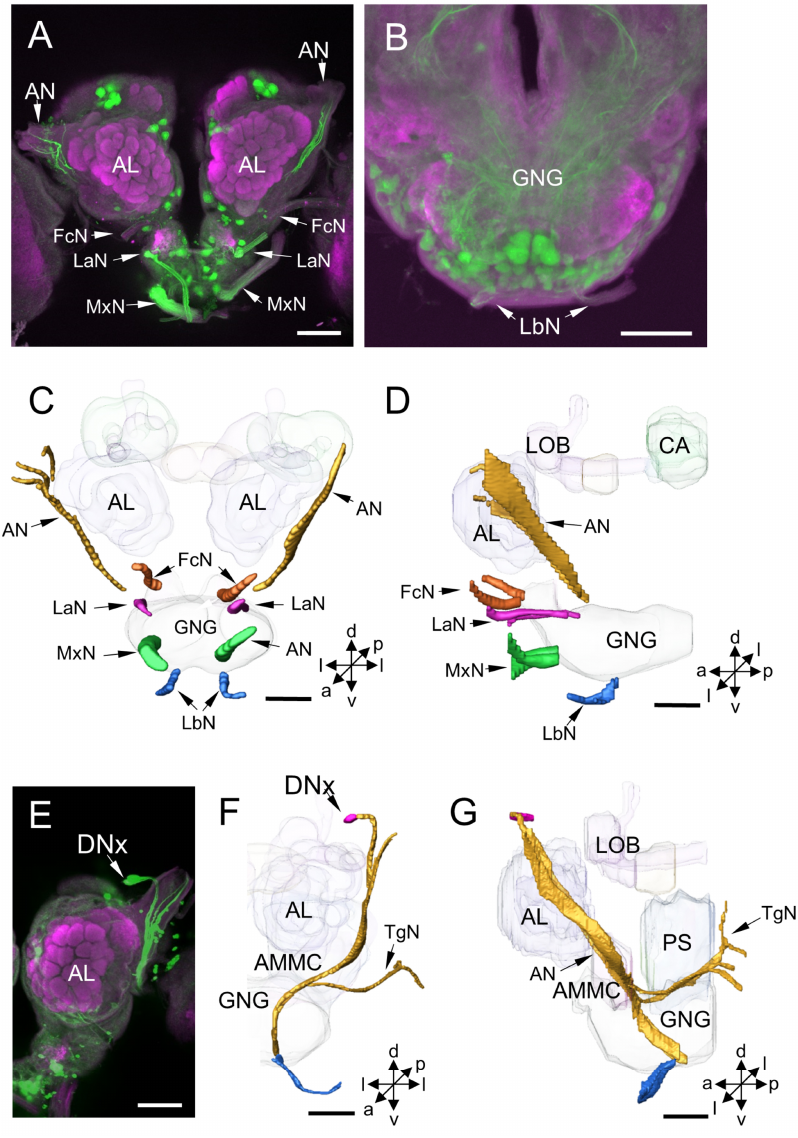
Figure 8. Peripheral nerves of H. armigera were labeled by backfilling: ( A , B ) projection views of confocal stack images of peripheral nerves by backfilling; ( C , D ) the anterior and lateral views of the three-dimensional reconstruction of peripheral nerves; ( E ) projection views of confocal stack images of antennal nerve with two stained somata DNx; and ( F , G ) the anterior and lateral views of the three-dimensional reconstruction showing DNx somata and primary neurites in the brain. AL, antennal lobe; AMMC, antennae mechanosensory and motor center; AN, antennal nerve; CA, calyx; FcN, frontal ganglion connective nerve; GNG, gnathal ganglion; LOB, mushroom body lobes; LaN, labral nerve; LbN, labial nerve; MxN, maxillary nerve; PS, posterior slope; TgN, tegumentary nerve. a, anterior; d, dorsal; l, lateral; p, posterior; v, ventral. Scale bars: 100 µ